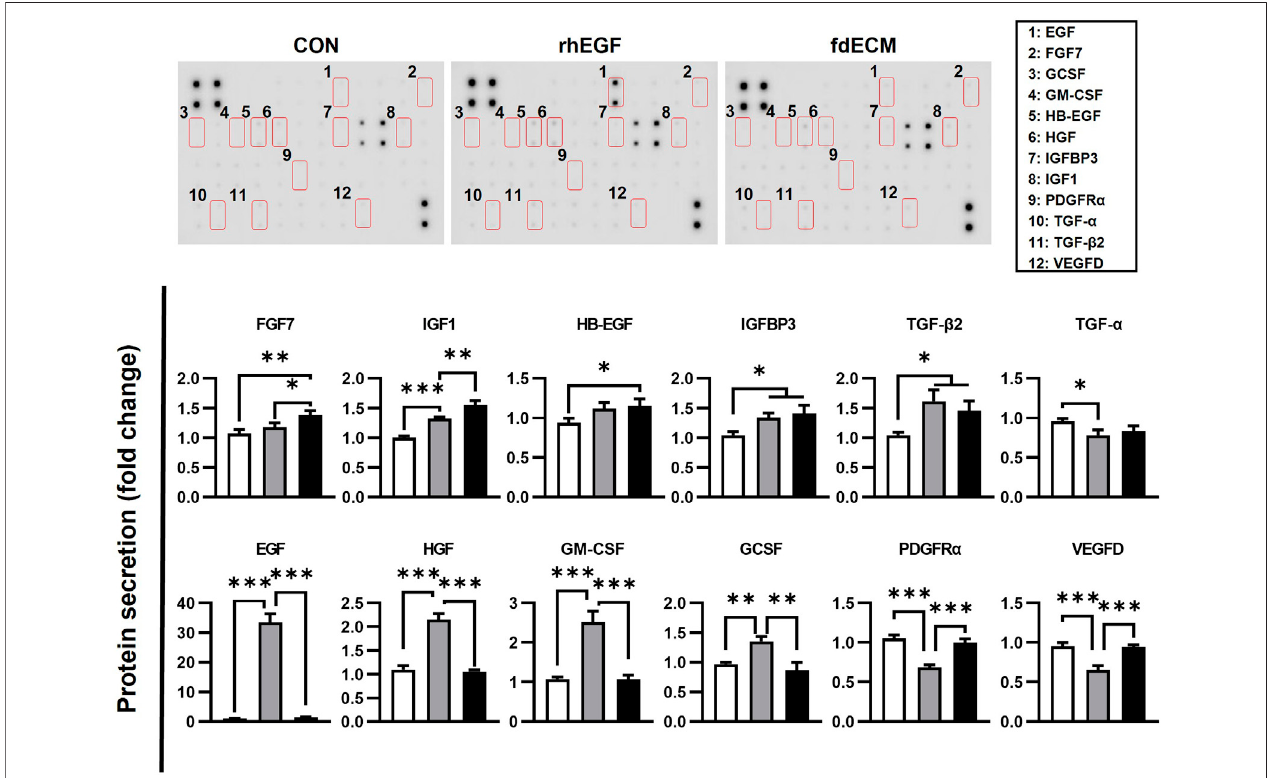
FIGURE6| Growthfactoranalysisof fi broblastsafterfdECMtreatment.Semi-quantitativeanalysisofgrowthfactorsandcytokinesofhumandermal fi broblastafter 48 hoffdECMtreatment.Forty-oneangiogenicfactorsweredetected,andthesigni fi cantlychangedfactorsaregraphed(boxdenotesfactors).Resultsareexpressedas mean ± standard deviation (SD). * p < 0.05, ** p < 0.01, *** p <